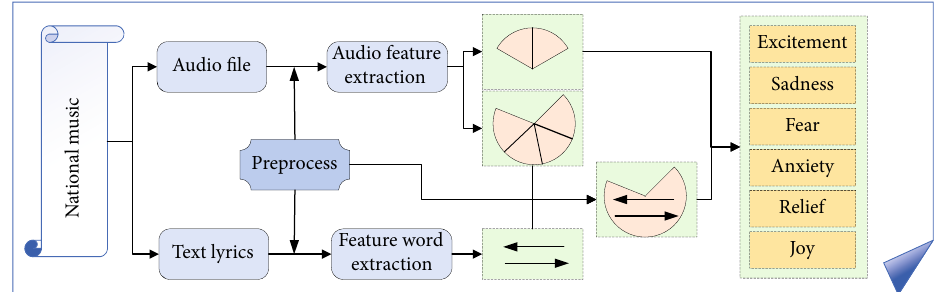
Figure 3: Structure diagram of speech emotion recognition system with semantic